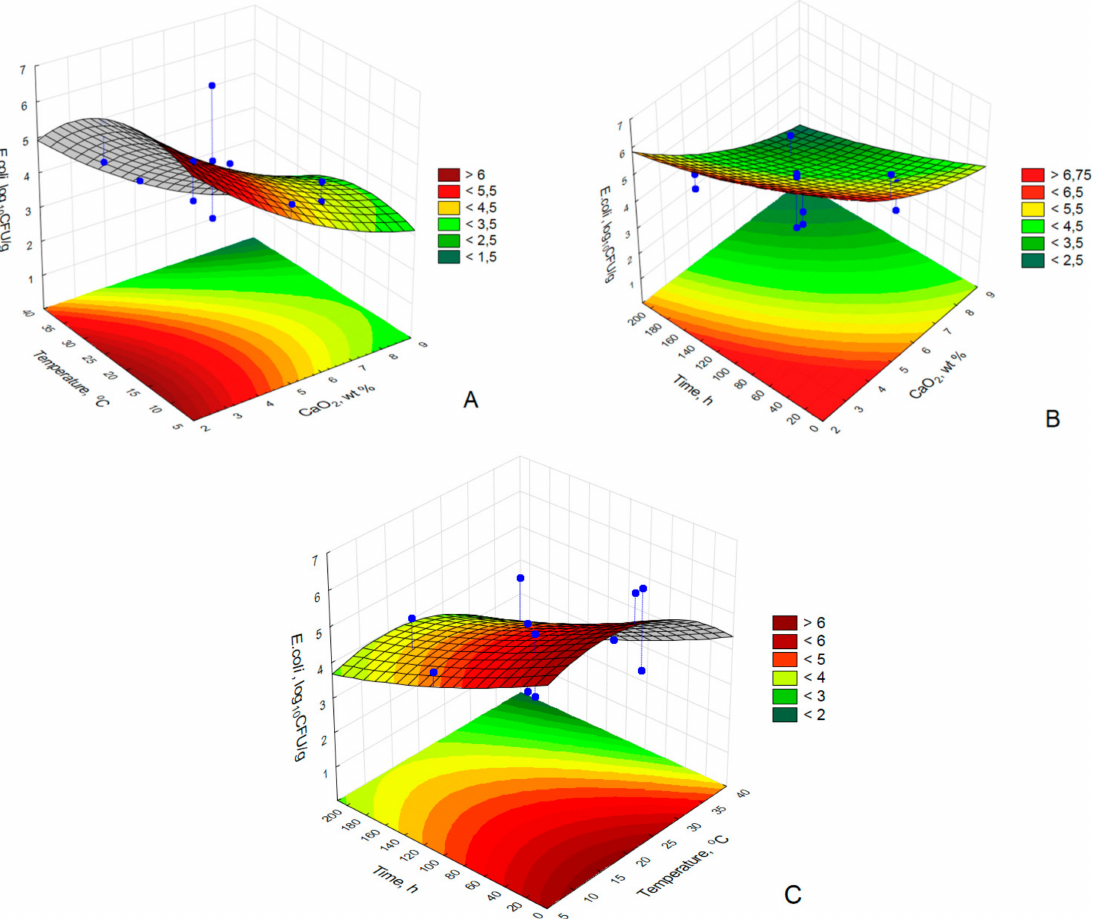
Figure 4. The interactions between: ( A ) temperature ( ◦ C) and CaO 2 concentration (wt %), ( B ) contact time (h) and CaO 2 concentration (wt %) and ( C ) contact time (h) and temperature ( ◦